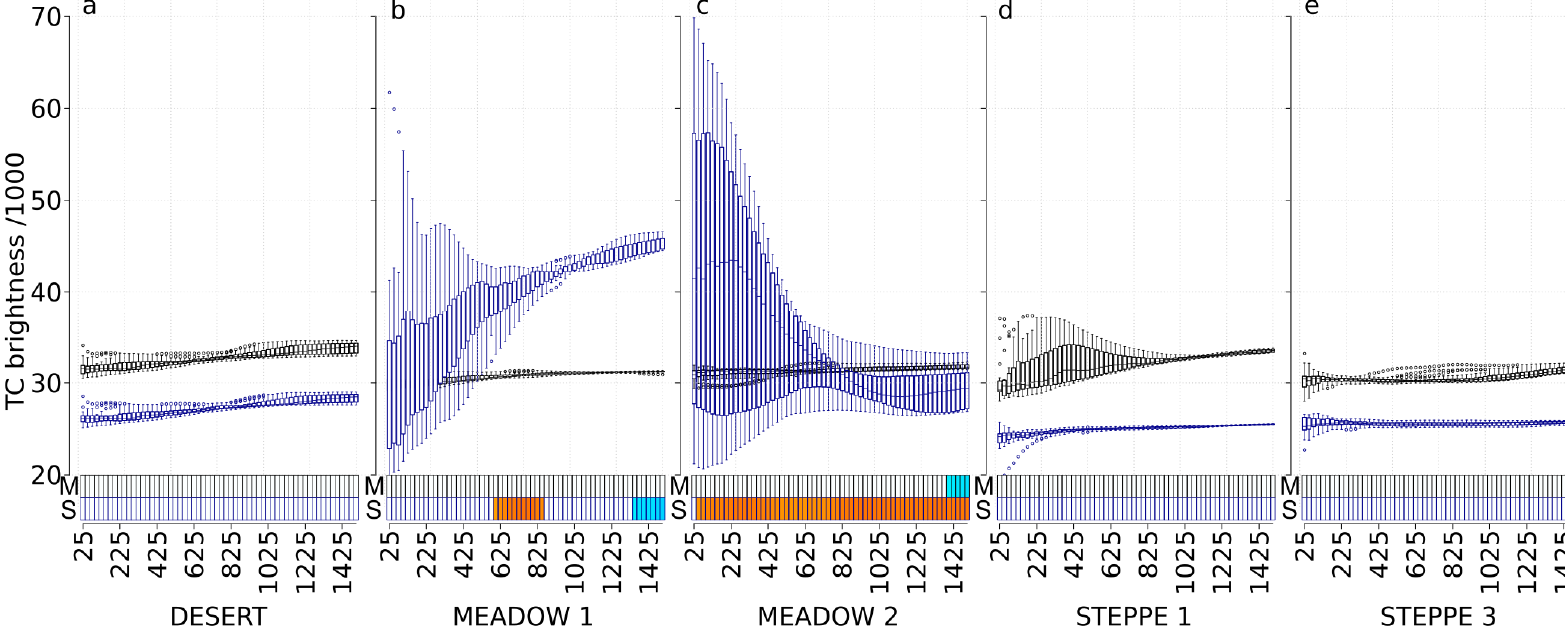
Figure 3 . Tasseled-cap brightness values at each scale and correlations with carabid abundances for the desert steppe (a), the meadow steppe 1 and 2 (b and c, respectively), and the typical steppe 1 and 3 (d and e, respectively). Boxplots represent the tasseled-cap brightness values with a black border for the May 2017 Landsat image (M) and with a dark-blue border for the September 2017 Landsat image (S). For each boxplot, a different background color indicates a significant difference in tasseled-cap brightness values using the Tukey test. The x -axis presents the different spatial scales used in the analysis (cardinal distances in meters representing circle radius ranging from 25 to 1500 m). The correlation with carabid abundances is represented with rectangles at the bottom of each graph, using a gradient from blue to red (dark blue corresponds to a negative correlation, dark red corresponds to a positive correlation, and white corresponds to no significant correlation).